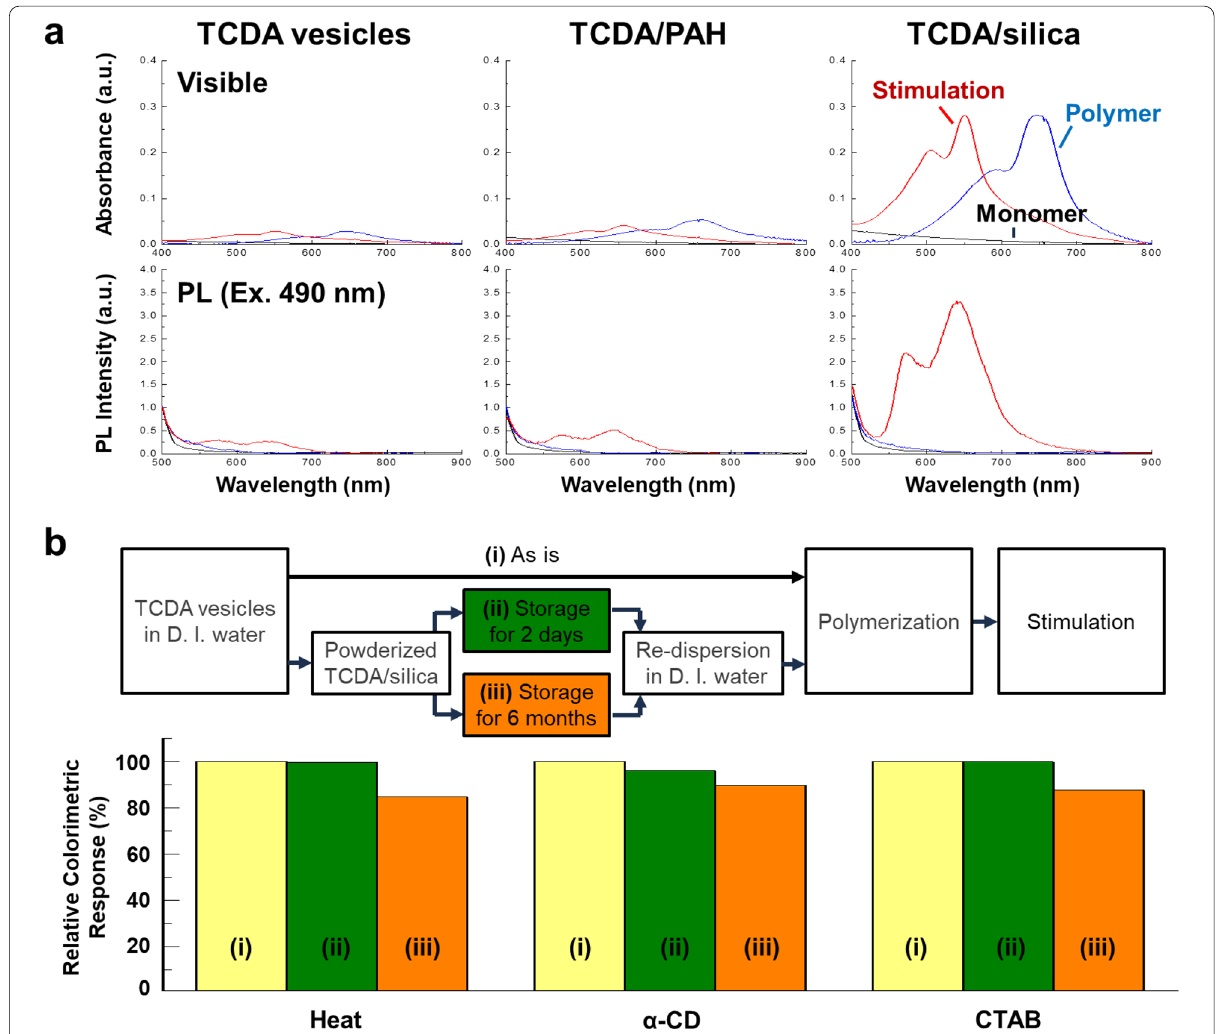
Fig. 4 a Visible and PL spectra of redispersed monomeric TCDA vesicles into deionized water with layer encapsulation and phases (black line: monomeric phase, blue line: polymeric phase, and red line: thermal stimulated phase (~ 110 °C)), b Sustainable sensing response of TCDA vesicles with layer encapsulation. Relative CR values of reactivity test of (i) unstored TCDA vesicles and redispersed TCDA/silica after (ii) 2 days and (iii) 6